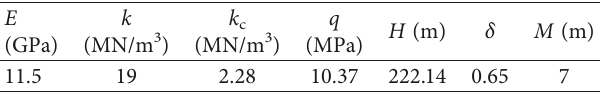
Table 1: The model calculation parameters in the Tingnan Coal